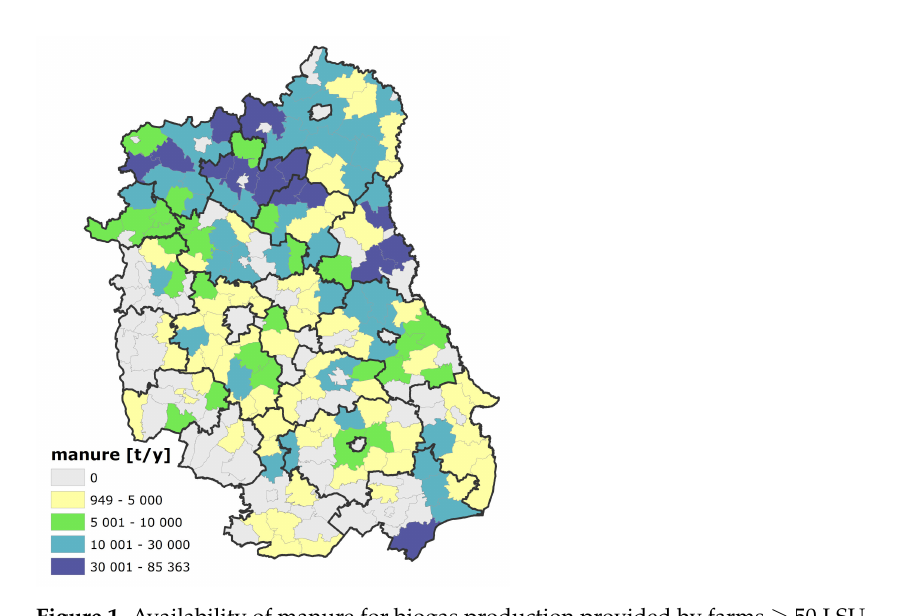
Figure 1. Availability of manure for biogas production provided by farms ≥ 50